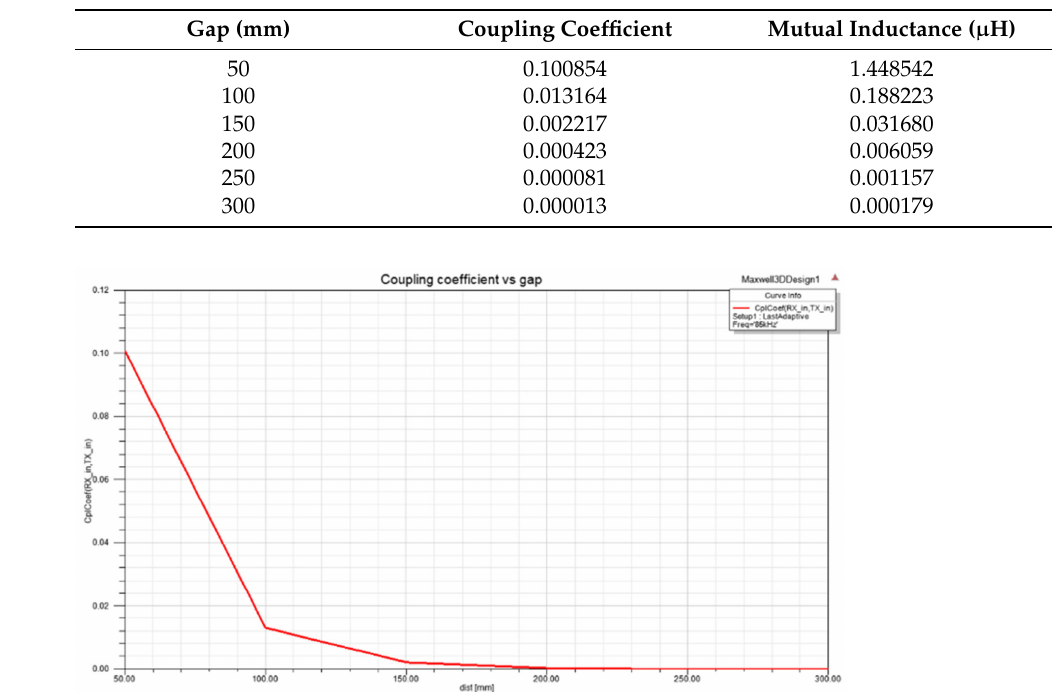
Table 4. Simulation results of rectangular coil model with ferrite and aluminum.